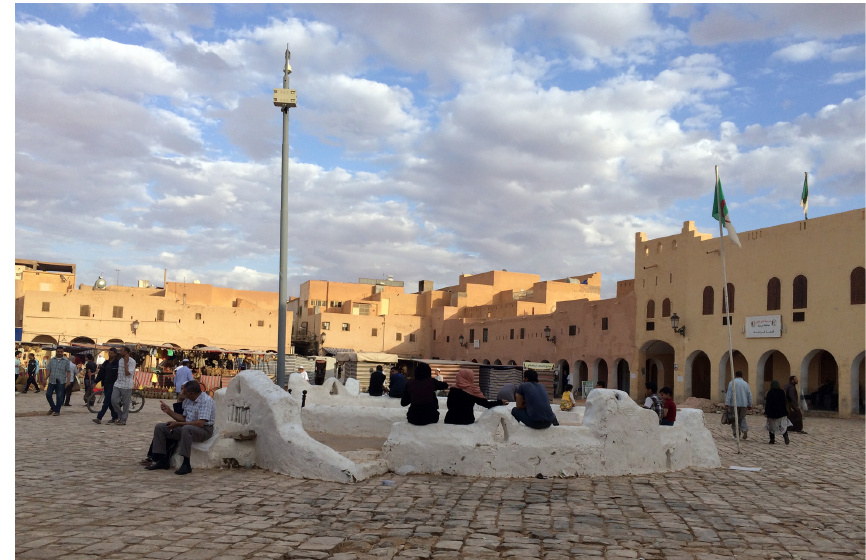
Fig. 10. The marketplace of Ghardaïa. Public benches for